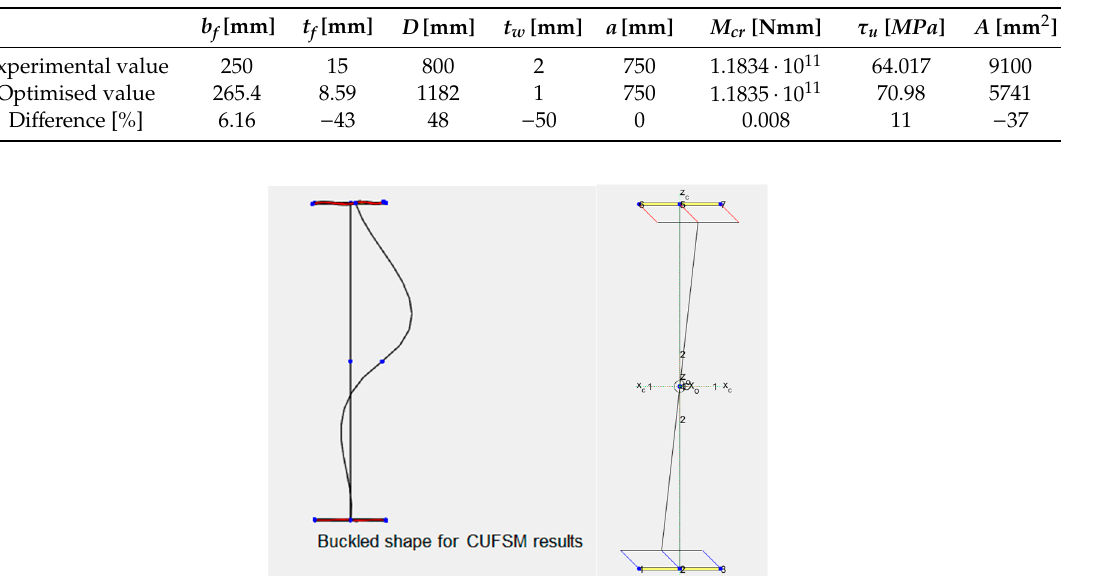
Table 3. Geometric and mechanical properties of the optimised cross-section with slender web.